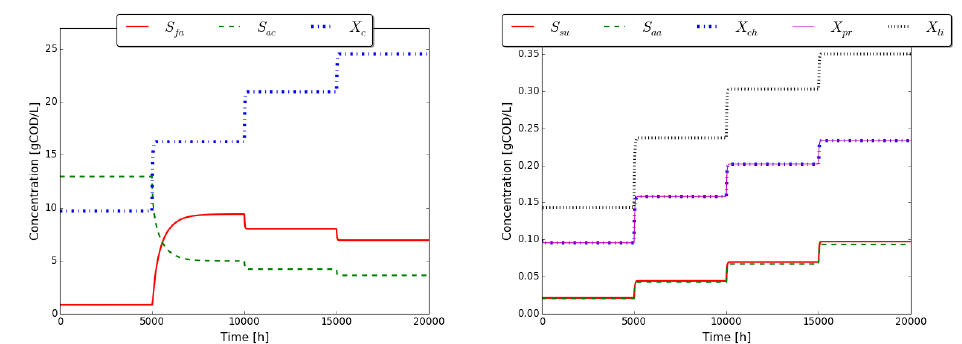
Figure 7. Time evolution of Q h 2 and Q ch 4 with variable D 1 and D 2 from Table 3.